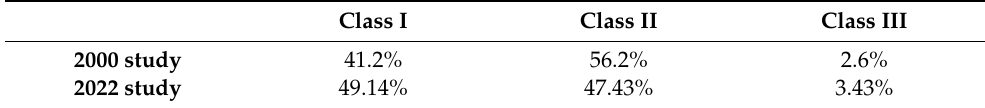
Table 15. Comparison of the distribution of skeletal classes in patients enrolled in the epidemiological studies of 2000 and